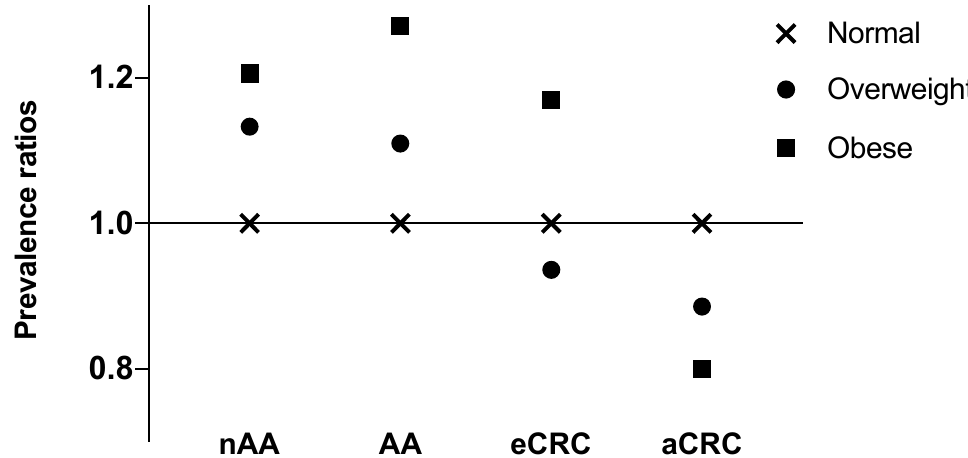
Figure 3. Prevalence ratios for BMI category and types of lesions. nAA—non-advanced adenoma, AA-advanced adenoma, eCRC—early CRC, aCRC—advanced CRC.